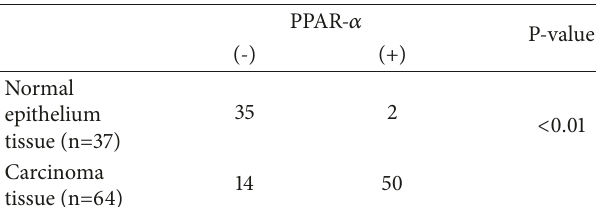
Table 1: PPAR- 𝛼 expression in the normal epithelium tissues (n=37) and colorectal carcinoma tissues